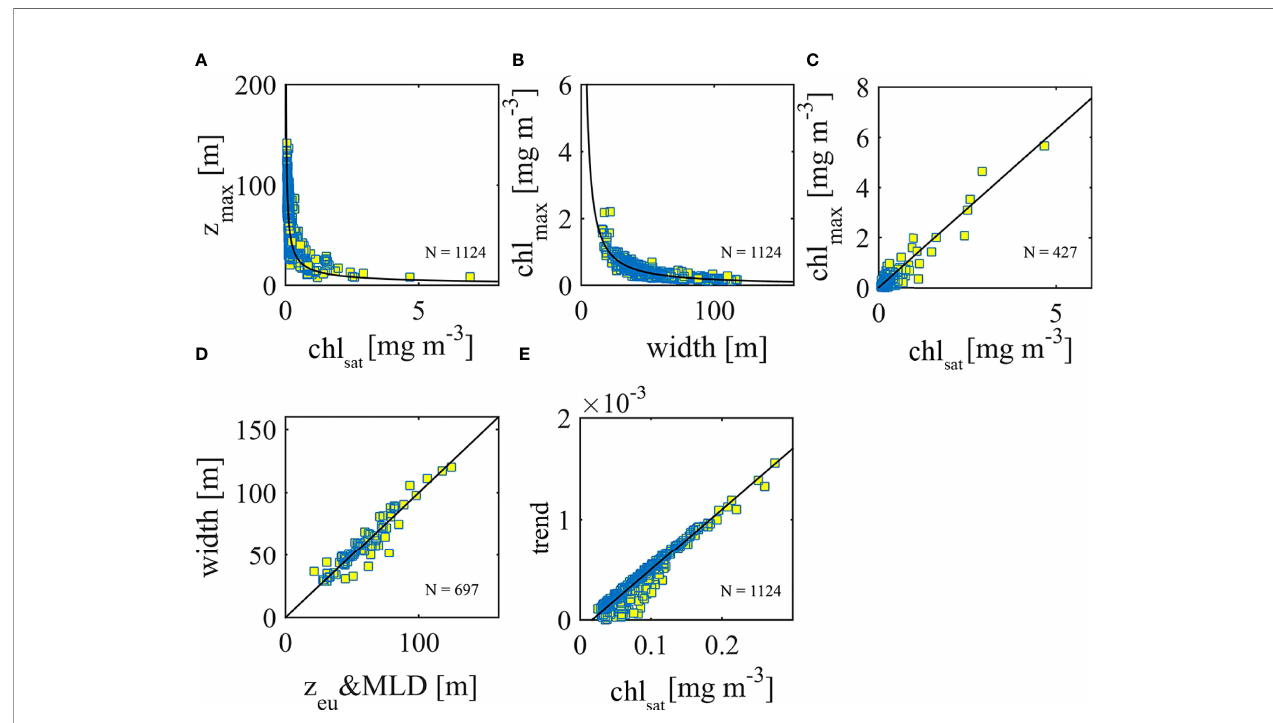
FIGURE 8 | Relationships between the shape-dependent parameters of the Chl-a vertical pro fi les and the surface concentrations derived from the OCRS Chl-a products. (A, B, E) are global relationships observed from all BGC-Argo Chl-a pro fi les. (C, D) are type-dependent relationships obtained from quasi-Gaussian and Gaussian pro fi les,